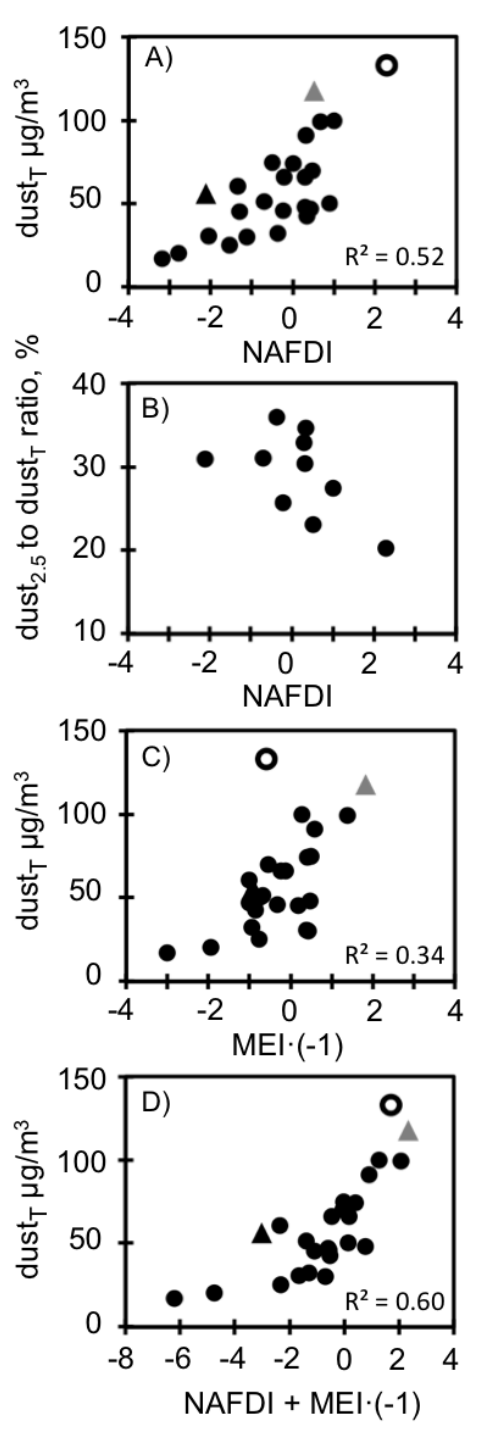
Figure 5. Scatterplot of dust versus NAFDI and MEI. Summer mean dust T at Izaña (1987–2014) versus NAFDI (a) , MEI (c) and NAFDI + MEI · ( − 1) (d) , and summer mean dust 2 . 5 -to-dust T ra- tio ( b , 2002–2014) versus NAFDI. Different symbols are used for the summer mean data of 2002 (black triangle), 2010 (grey triangle) and 2012 (white filled symbol) for examining how some data may have different associations with NAFDI and